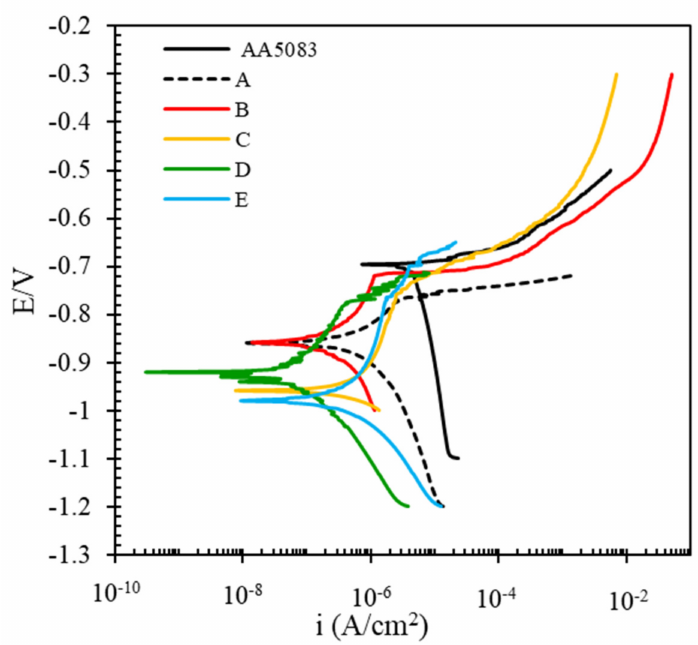
Figure 3. The electrochemical polarization curves of cerium coated AA5083 were prepared under different pretreatment conditions (corrosive solution 3.5 wt.% NaCl).